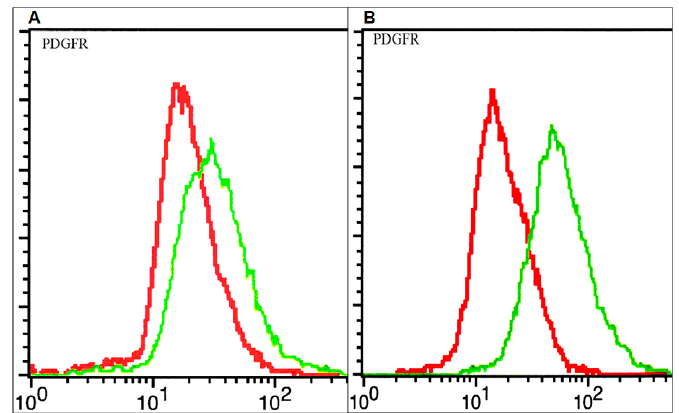
Figure 1. Membrane expression of Platelet-derived growth factor receptor (PDGFR) on glioblastoma cells: 11 high grade glioma (HGG) cells ( A ) and 15 HGG cells ( B ). Cells were stained with a plating efficiency (PE)-conjugated anti-PDGFR (green line) or a PE-labelled isotype control (red line) antibody and analyzed by flow cytometry as described in materials and methods.